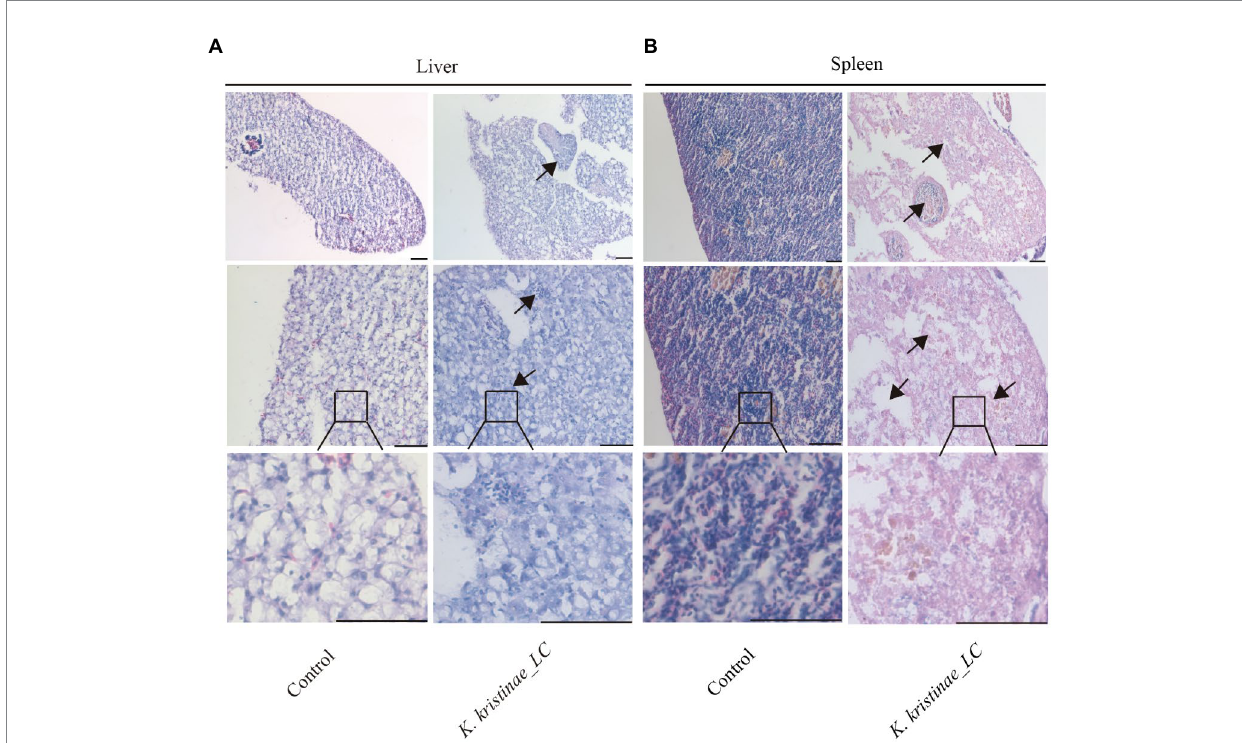
FIGURE 7 Histopathological observation of the liver and spleen infected with K. kristinae_LC . H&E-stained slices of the infected fish organs at 48 h post-infection for liver (A) and spleen (B) . The scale bar is 50 μ